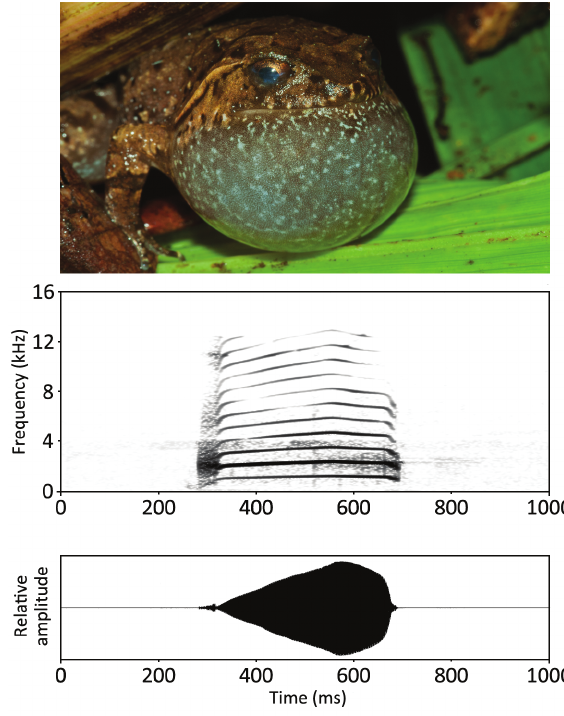
Figure 8. Audiospectrogram and corresponding oscillogram of the advertisement call of Plethodontohyla laevis recorded at Betampona Strict Nature Reserve on 18 November 2007 (22:30 h, 21 °C). Calling male MRSN A6340